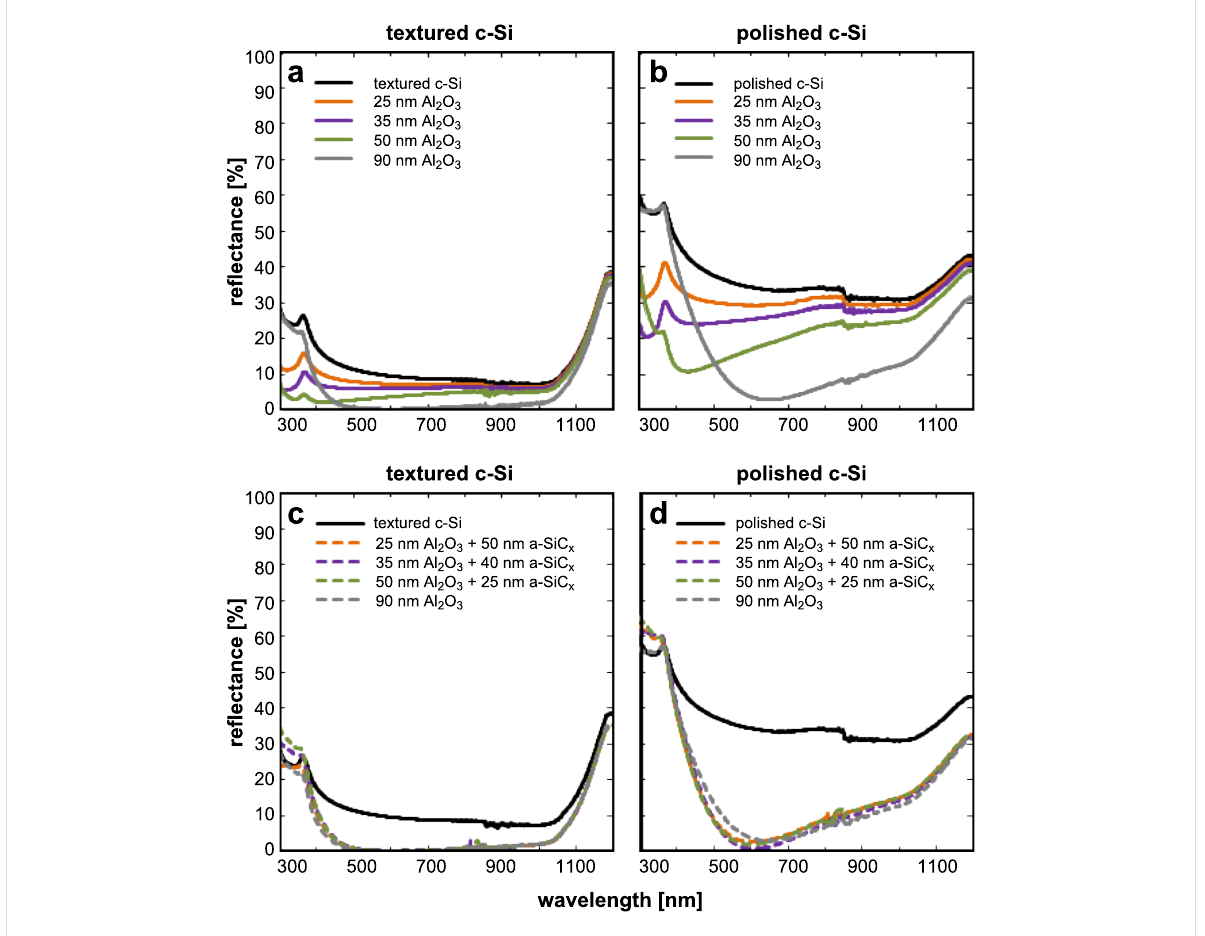
Figure 3: Reflectance curves of Al 2 O 3 -coated randomly textured c-Si (a) and polished c-Si (b) for different film thicknesses. Reflectance curves of